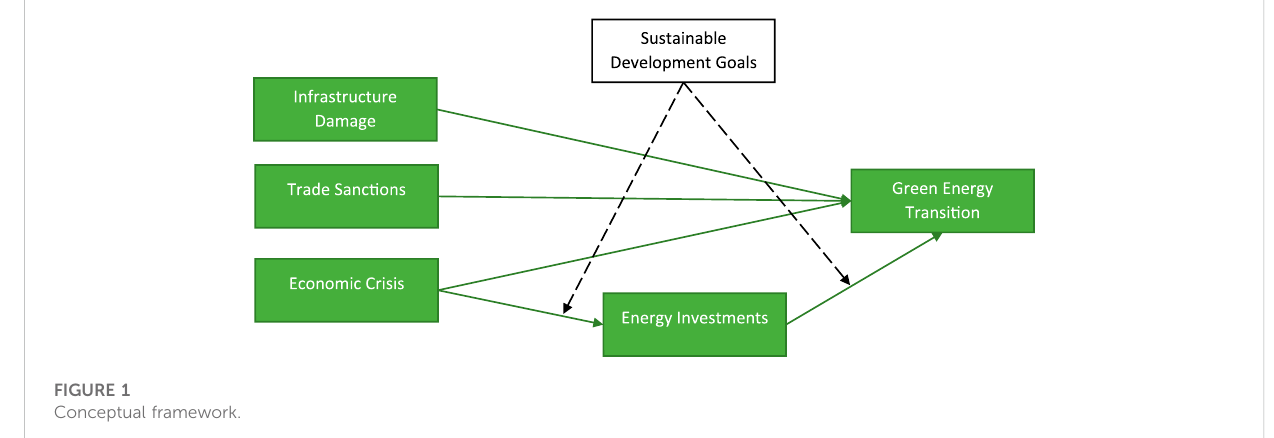
FIGURE 1 Conceptual